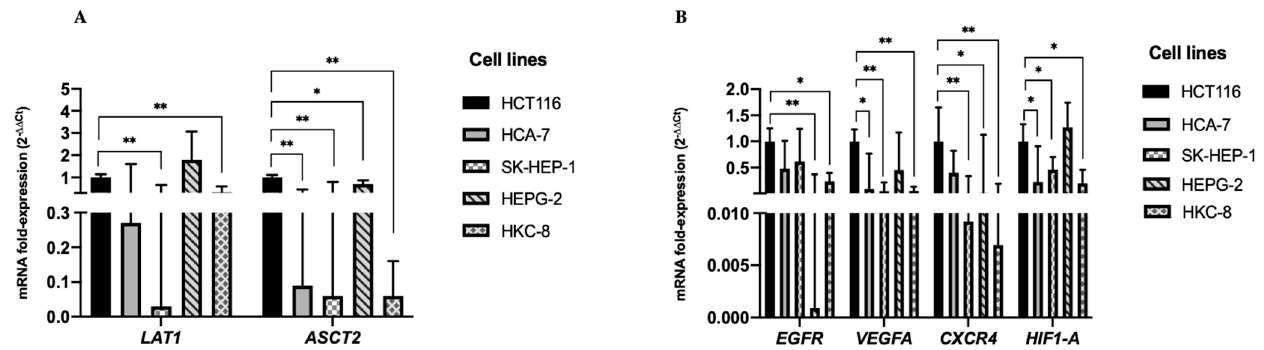
Figure 1. The bars represent the fold change of the mRNAs’ expression, normalized to B2M . Expression levels shown are means of three technical replicates for each sample. ( A ) The graphs show the increase of LAT1 and ASCT2 mRNA and ( B ) EGFR , VEGFA , CXCR4 and HIF1–A mRNAs expression levels in HCT 116 cells, compared to the others cell lines in the analyzed panel. (Mean ± Std. Error, ** p < 0.001, * p < 0.05).